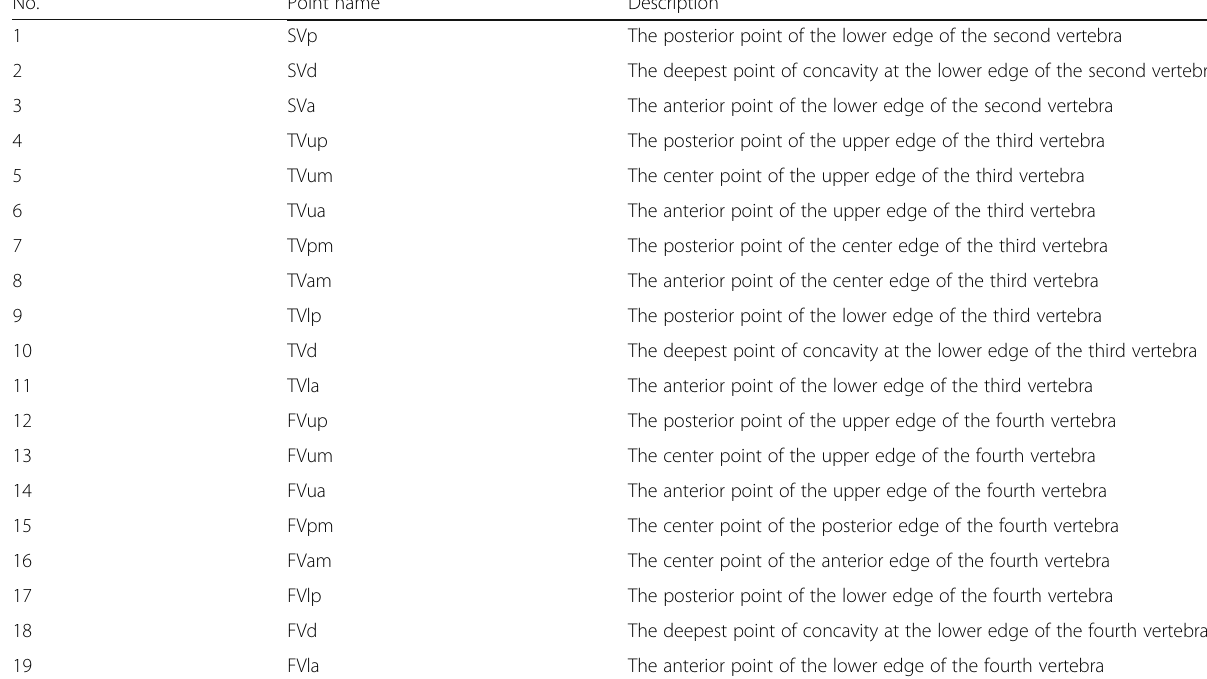
Table 1 The cervical vertebrae reference points No.